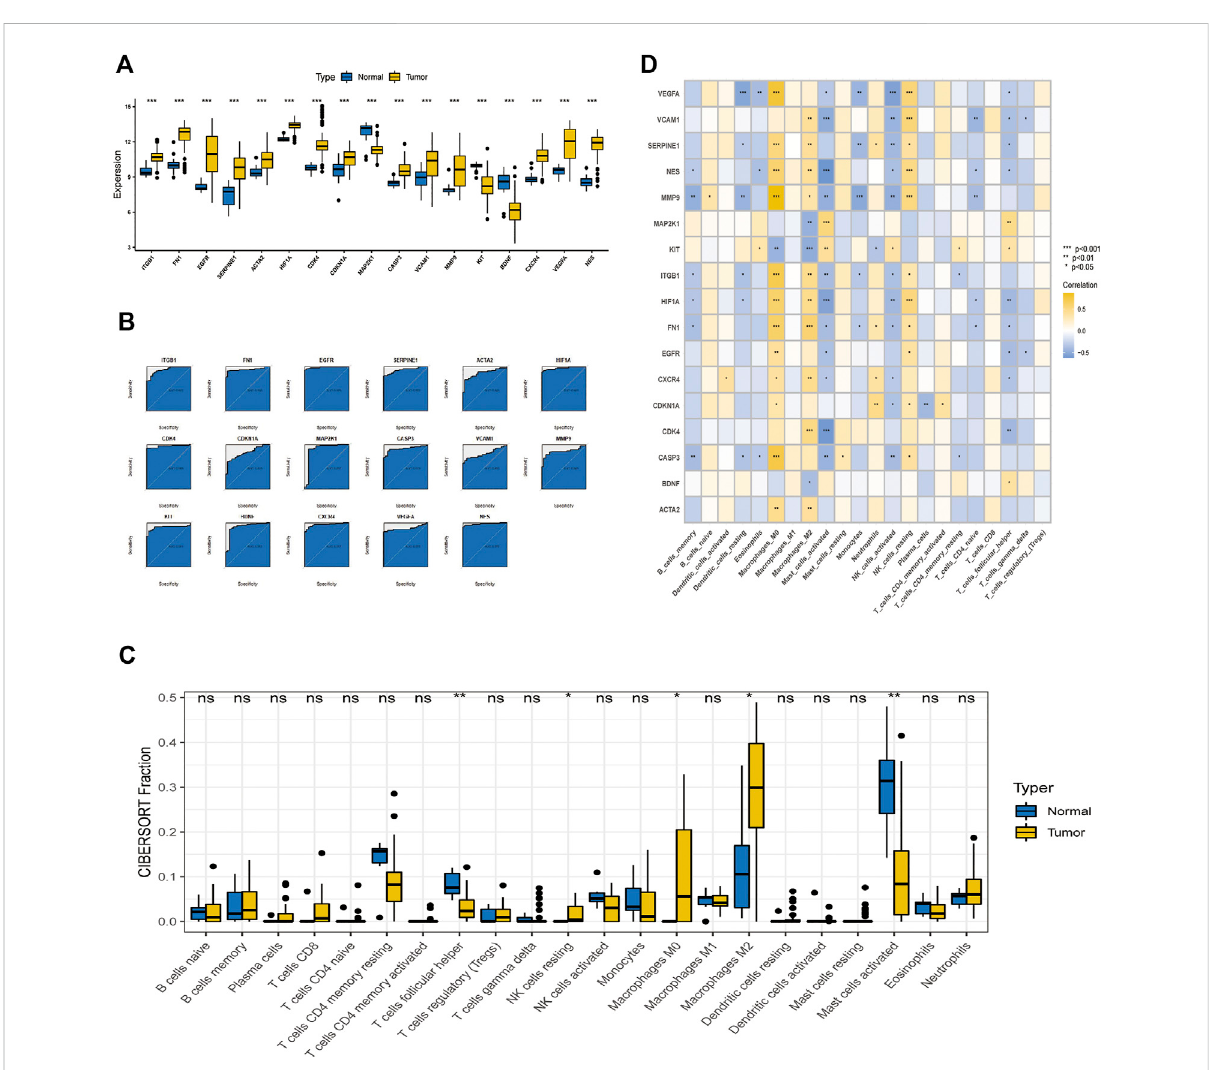
FIGURE 7 Relationship between crucial cluster genes and immune in fi ltration and receiver operating characteristic (ROC) prediction. (A) Differential expression of crucial subgroup genes in tumor and control tissues. (B) ROC curves of essential subcluster genes predicting disease onset. (C) Differential expression of immune function between tumor and control tissues. (D) Relationship between crucial cluster genes and immune in fi